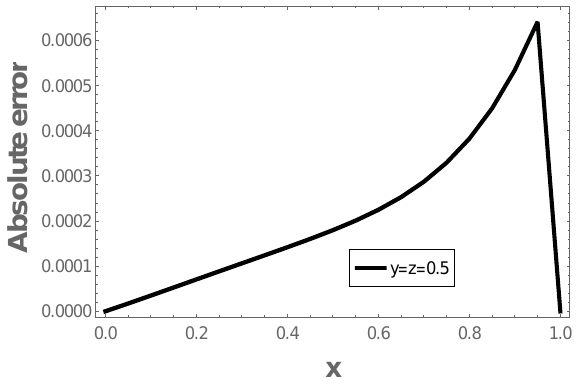
Figure 10: Absolute error y = z = 0.5